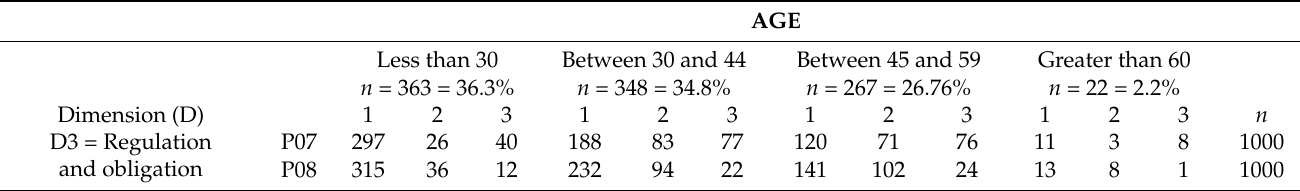
Table 5. Count by age group of the participating sample for dimension